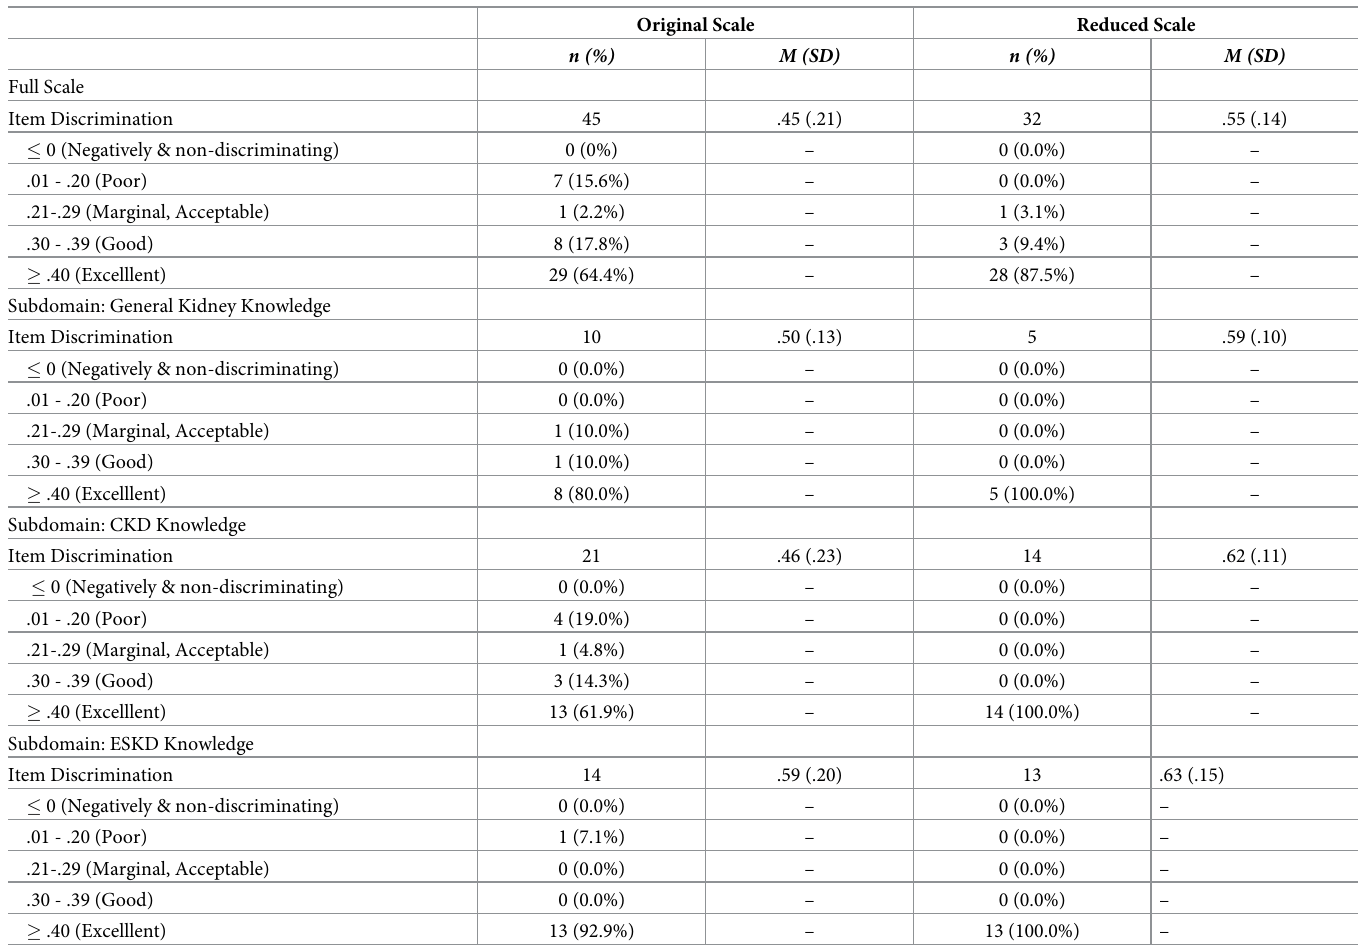
Table 3. Item discrimination index